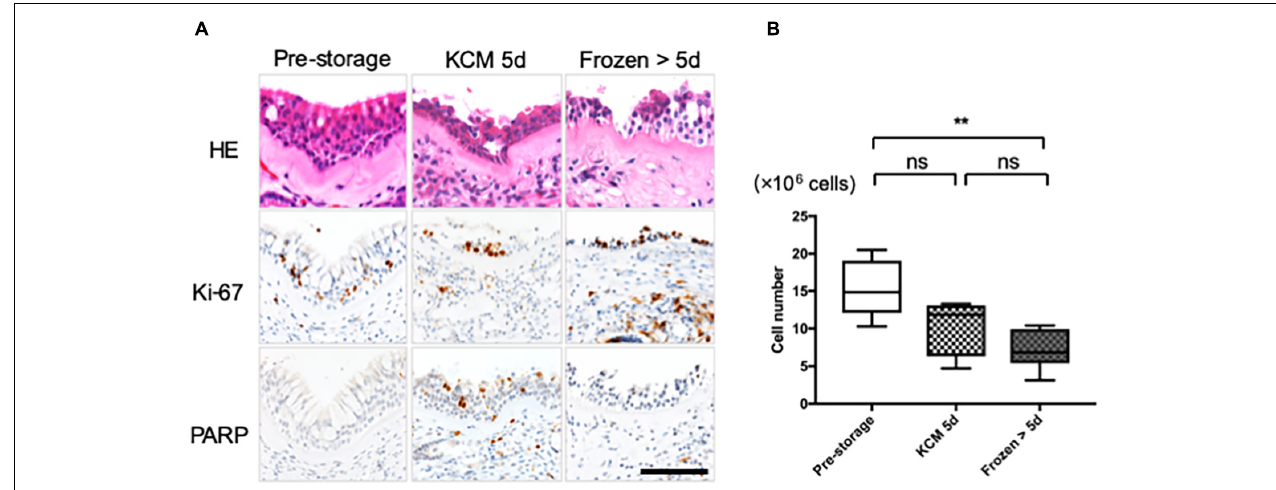
FIGURE 1 | Nasal cells expanded from tissue refrigerated for 5 days and frozen–thawed tissue. (A) Hematoxylin and eosin (HE) staining and immunohistological evaluation of the expression of Ki-67 and PARP in pre- and post-storage nasal tissue. (B) Cell number was determined for cells cultured from each explant in eight dishes under each condition. Scale bar = 100 µ m. ** P < 0.01; ns, not